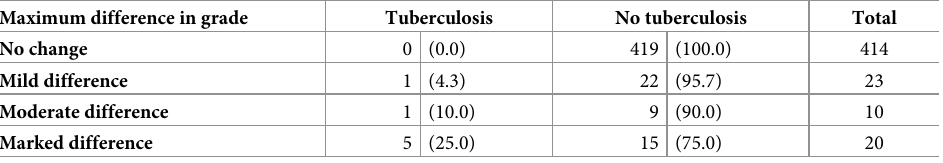
Table 4. Maximum difference in QFT-GIT grade with borderline zone and the development of tuberculosis ( P - value < 0.001). Maximum difference in grade Tuberculosis No tuberculosis Total No change Mild difference Moderate difference Marked difference Abbreviation: QFT-GIT, QuantiFERON-TB Gold